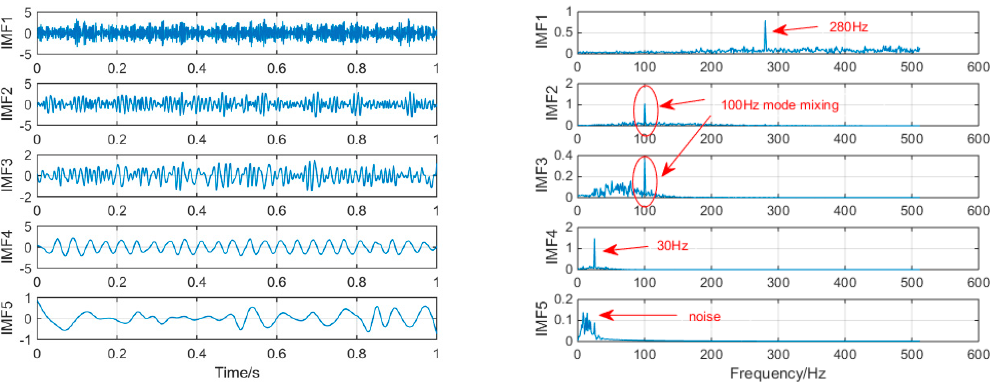
Figure 3. The spectrum of IMFs after EEMD and its corresponding spectrum.